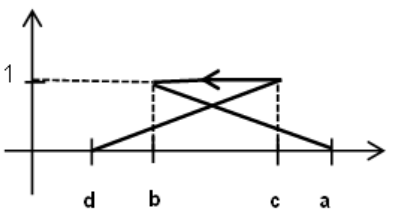
Figure 3. Membership relation of improper ordered FN.